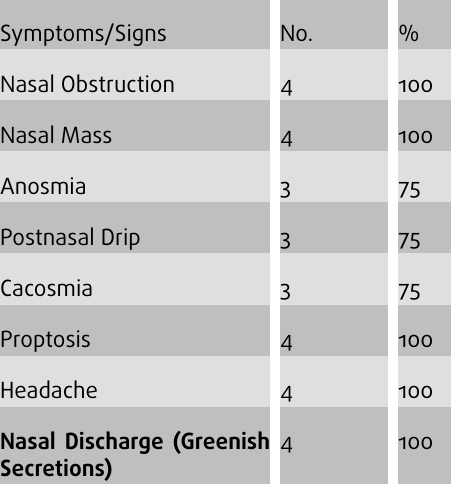
Table 2: Clinical